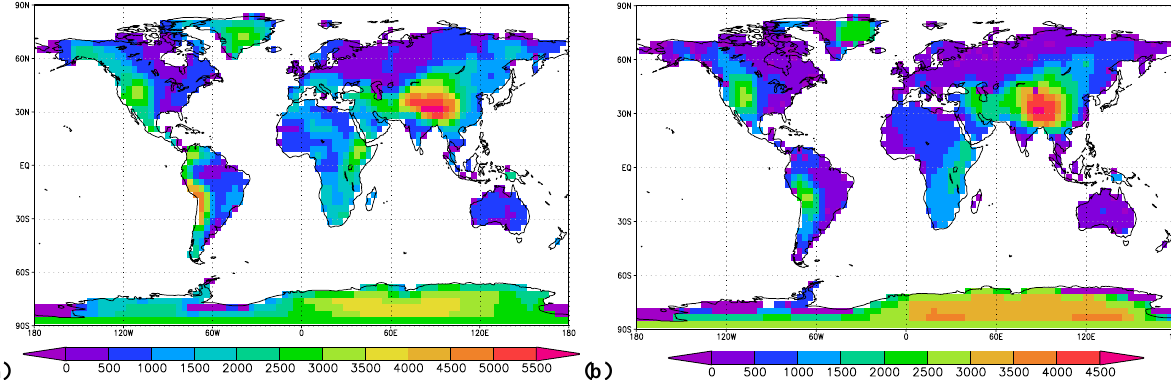
Fig. 2. Comparison of the orographic peaks elevation in units of m as used in the PI control simulation (a) to its mid-Pliocene counterpart (b) , which has been generated from a coarse mid-Pliocene